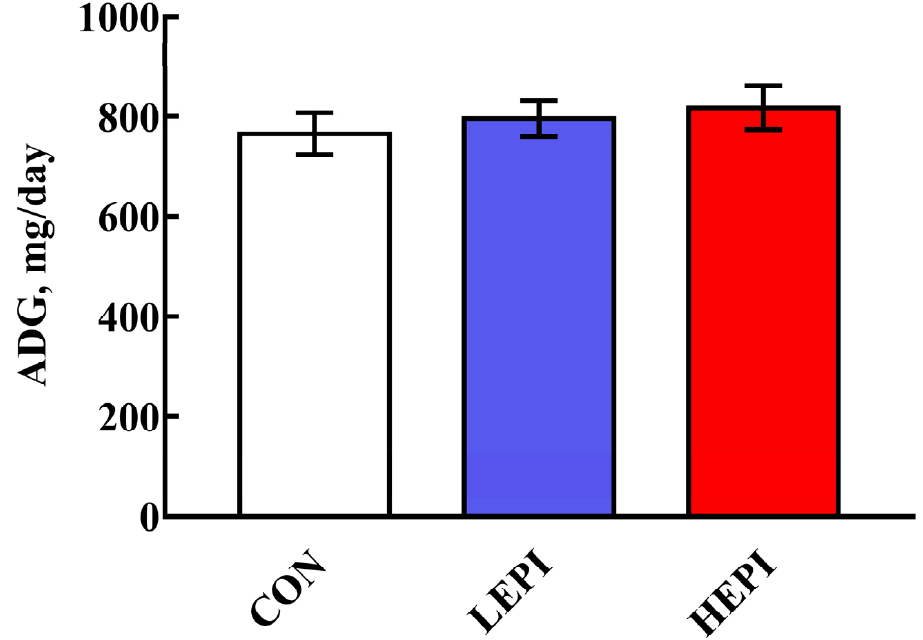
Figure 1. Effects of epicatechin on the growth performance of mice. Data are expressed as the means (12 mice/treatment), with standard errors represented by vertical bars. CON group: control group—mice received a standard diet; LEPI group—mice received a standard diet supplemented with 50 mg/kg epicatechin; HEPI group—mice received a standard diet supplemented with 100 mg/kg epicatechin; ADG—average daily gain.